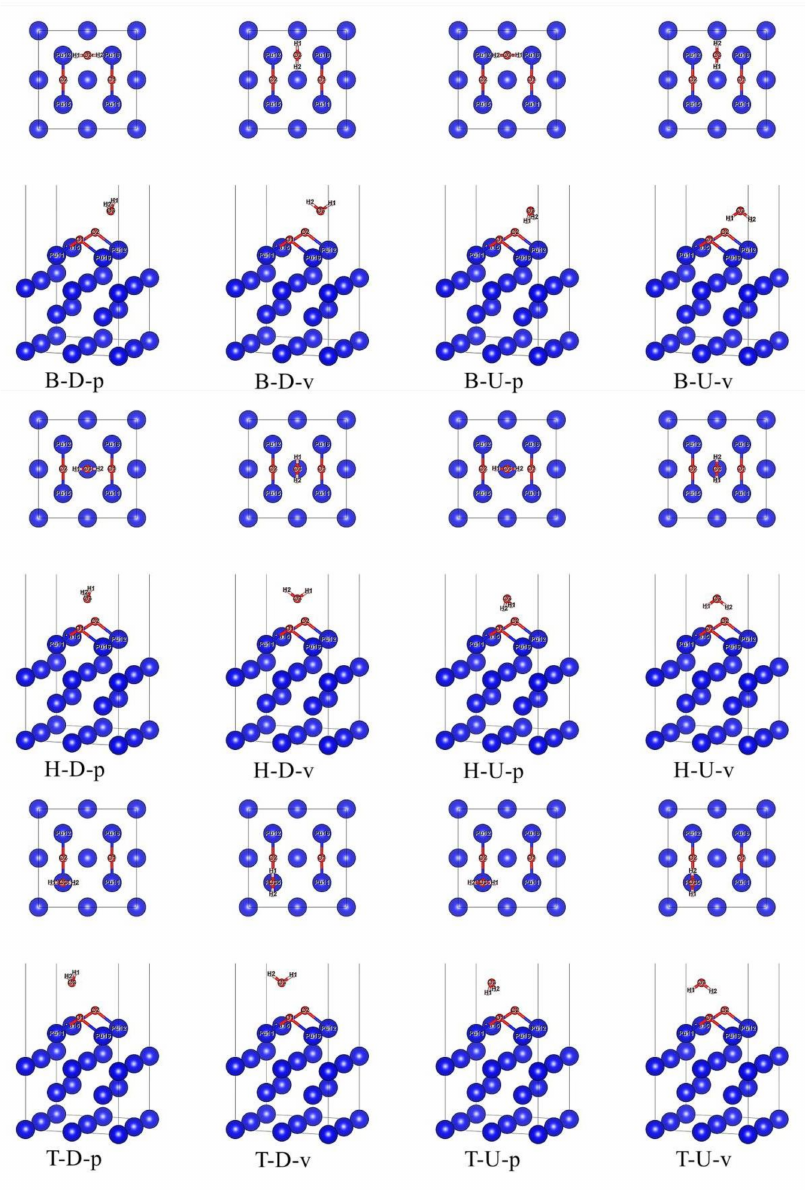
Figure 3. Initial co-adsorption model based on the most stable adsorption configuration of O 2 single